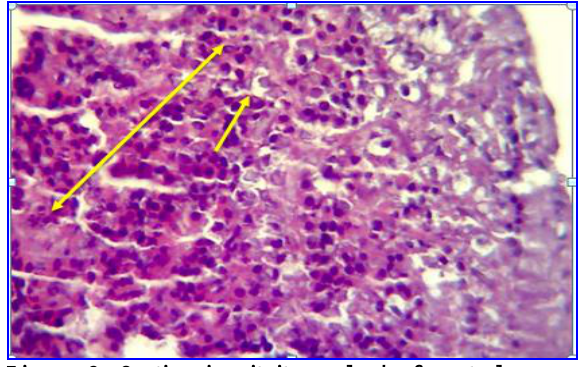
Figure, 3: Section in pituitary gland of control group shows normal structure of cellular composition of the pars distalis, chromophobes cells ( ) and chromophils cells ( ) (H and E stain